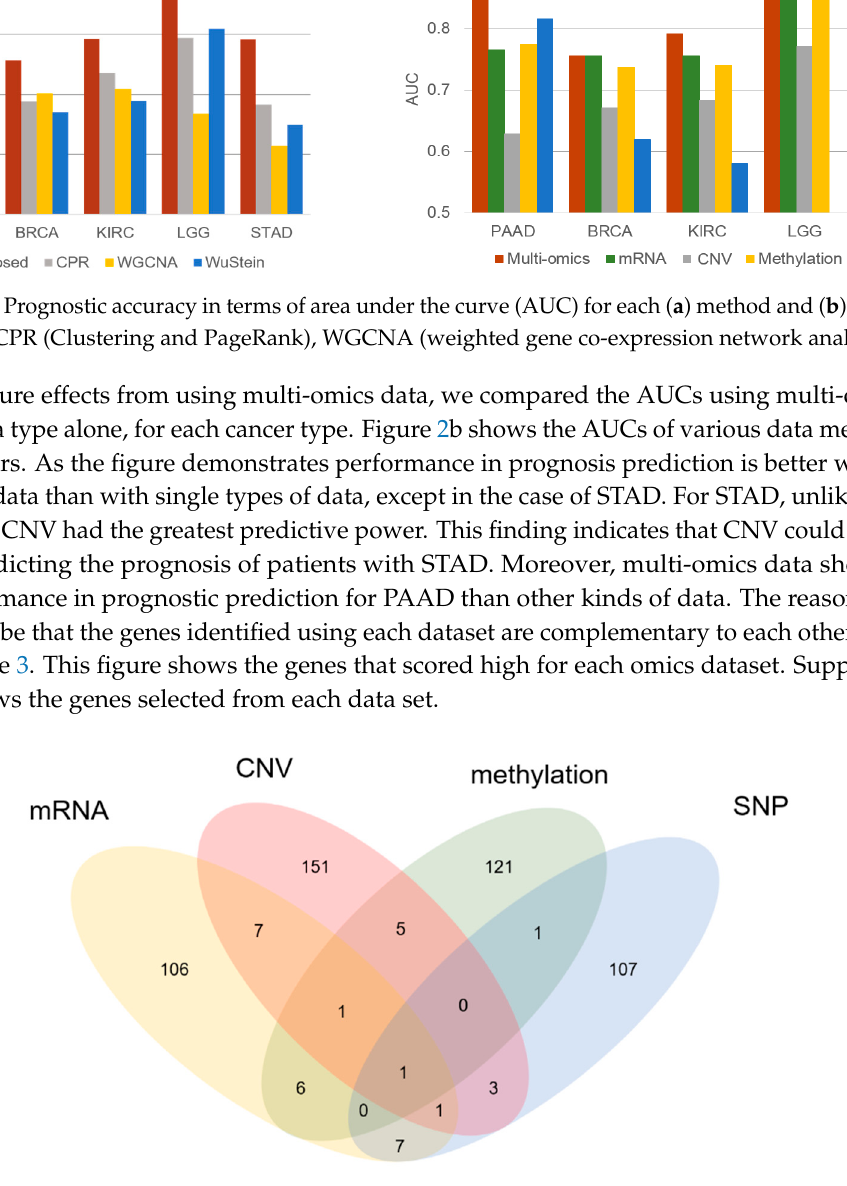
Figure 3. Number of biomarkers for each kind of omics data in PAAD. Venn diagram showing the biomarkers selected when applying our method to mRNA, CNV, DNA methylation, and SNP data.